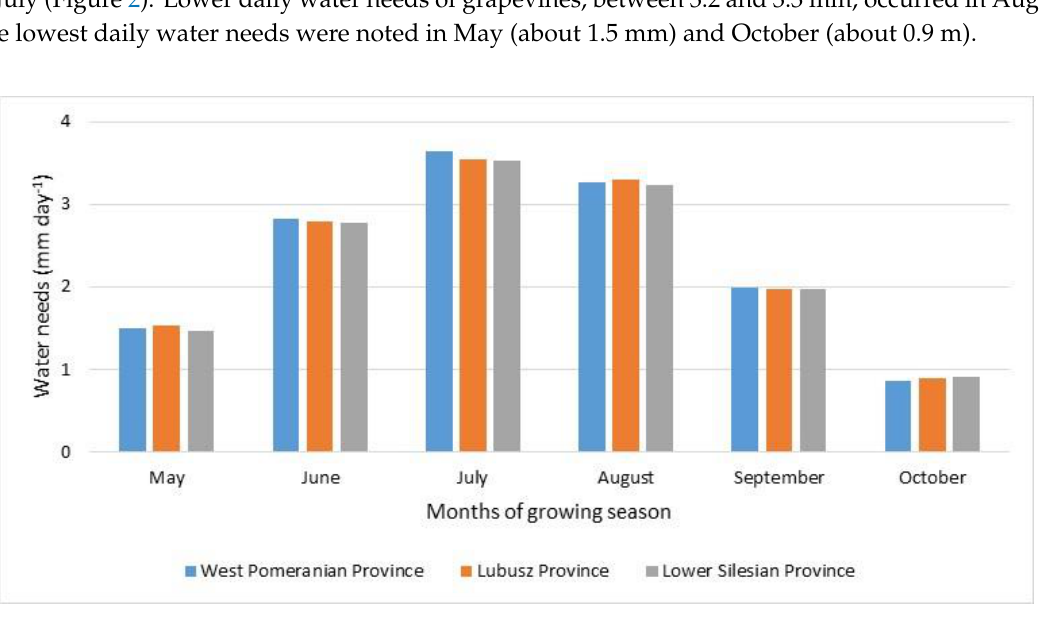
Figure 2. Daily water needs of grapevines in western Poland during the growing season (May–October).